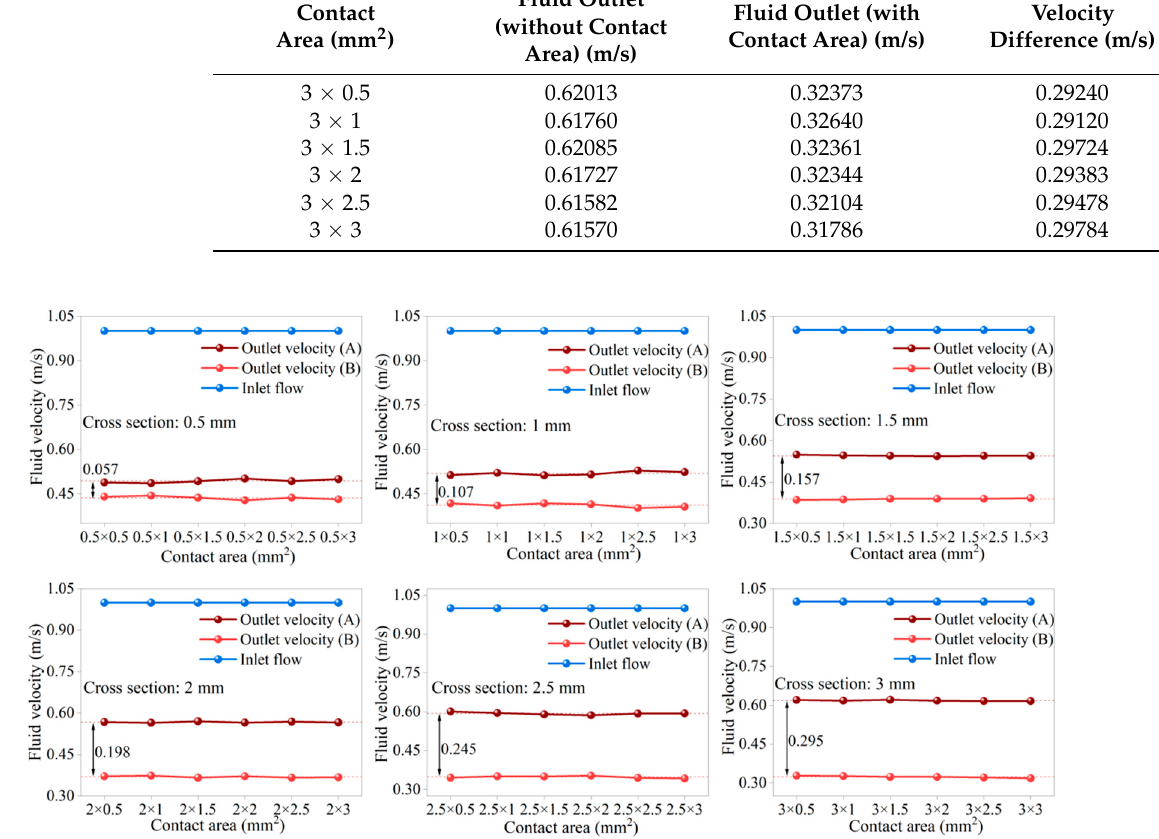
Figure 7. Variations in the velocities at the outlets of the bifurcated fractures for a constant cross-section.